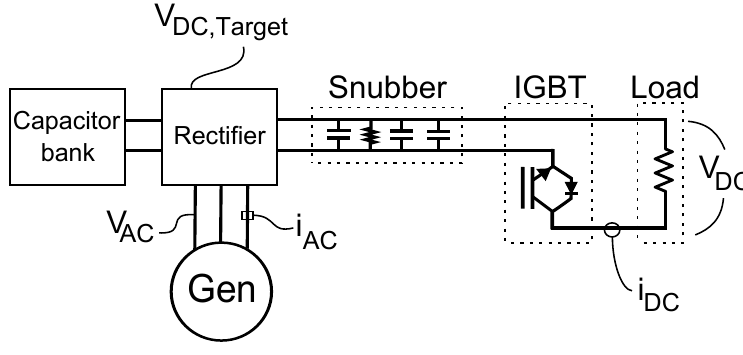
Figure 4. The DC load control consisting of a rectifier, capacitor bank, IGBT with a snubber circuit and resistive load.